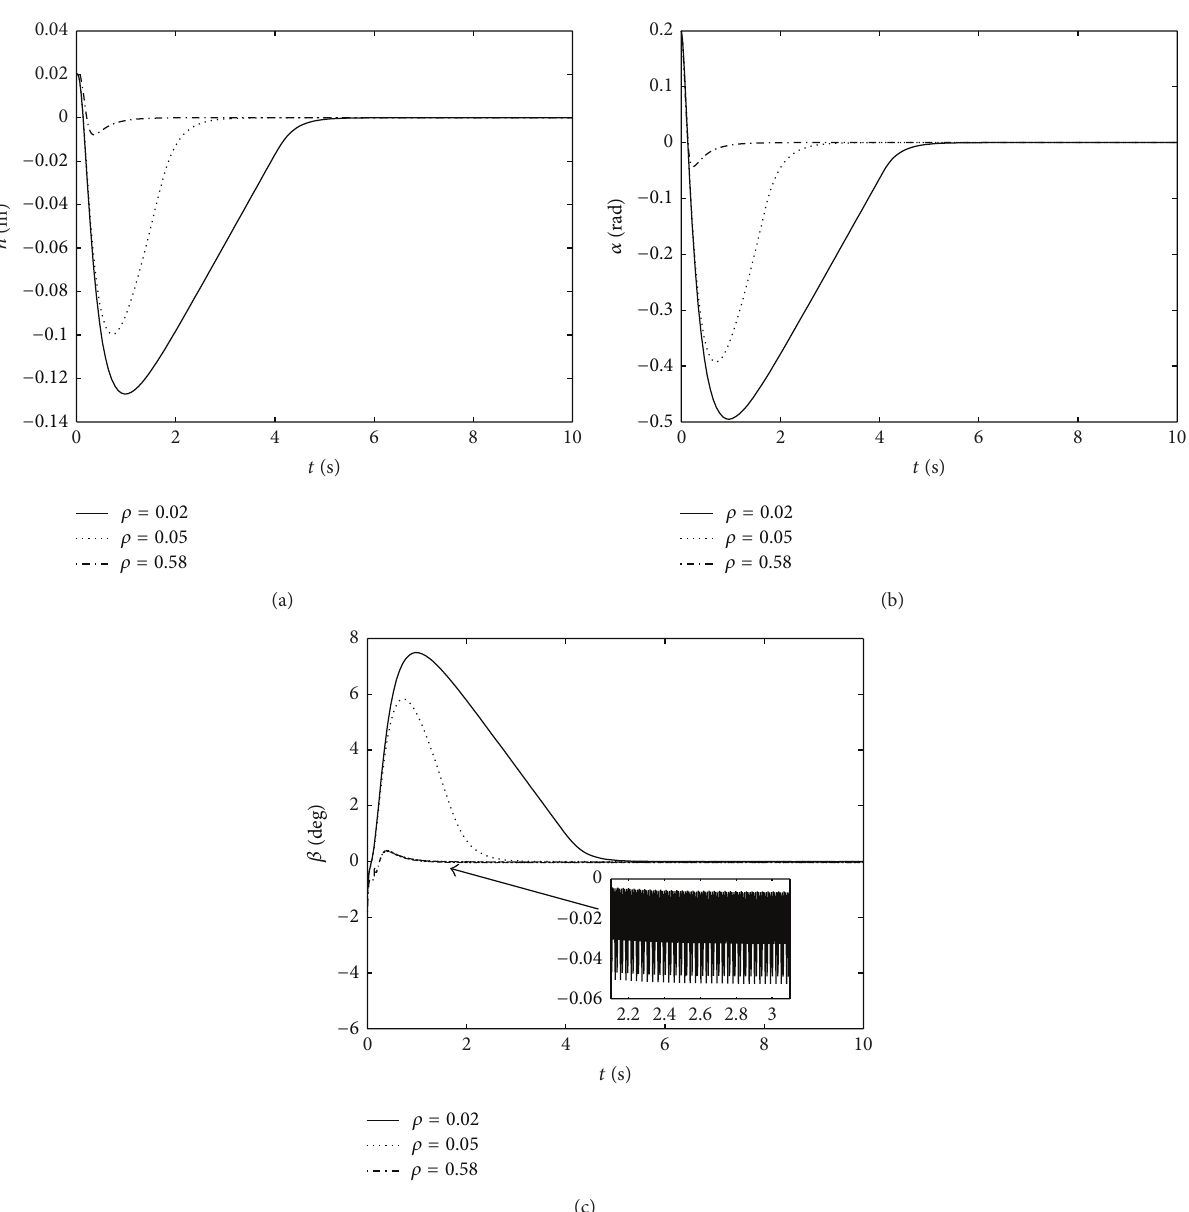
𝑈 = 13 m/s. The open-loop eigenvalues of the system are in the right half plane at 2.9046+𝑗18.3698 and 2.9046−𝑗18.3698 and the remaining eigenvalues are in the left half